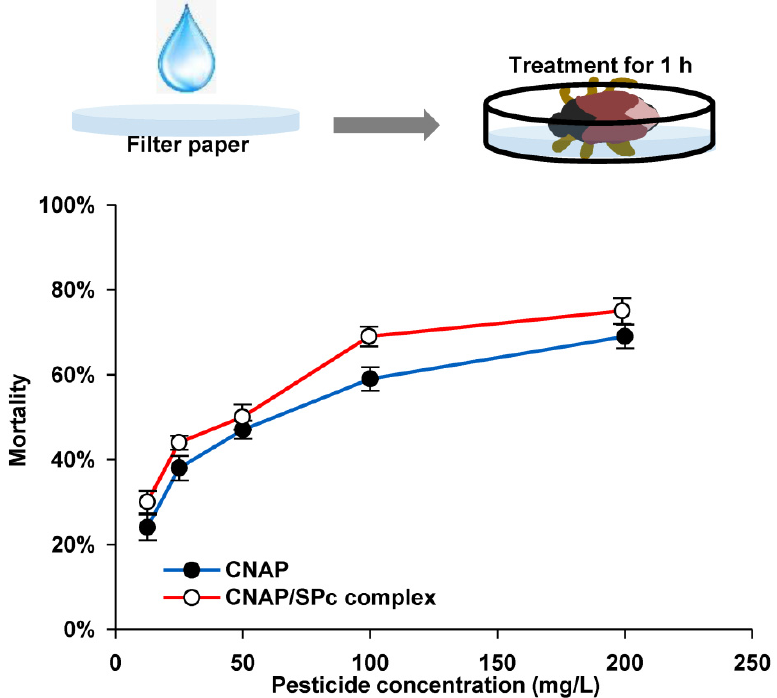
Figure 5. Toxicity of CNAP/SPc complex against the adults of Orius sauteri at 48 h after the treatment. n = 10. Table 4. Toxicity of CNAP and CNAP/SPc complex against adults of Orius sauteri at 24 h after the treatment.